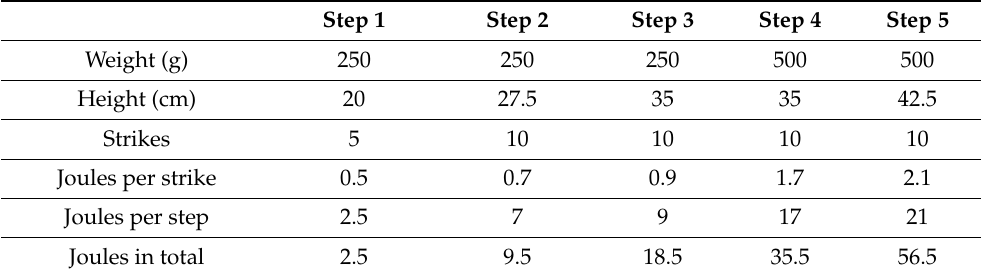
Table 2. Incremental biomechanical test protocol simulating the mallet strikes during stem impaction.